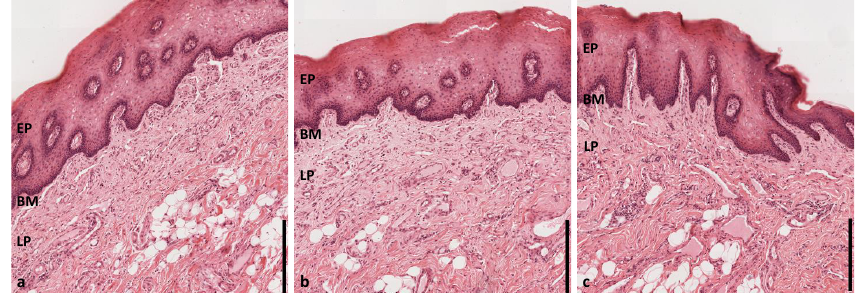
Figure A6. Supplementary HE stained histological cross sections of the human buccal mucosa [44]. EP: epithelium, BM: basement membrane, LP: lamina propria, Scale bar: 200 µ m.